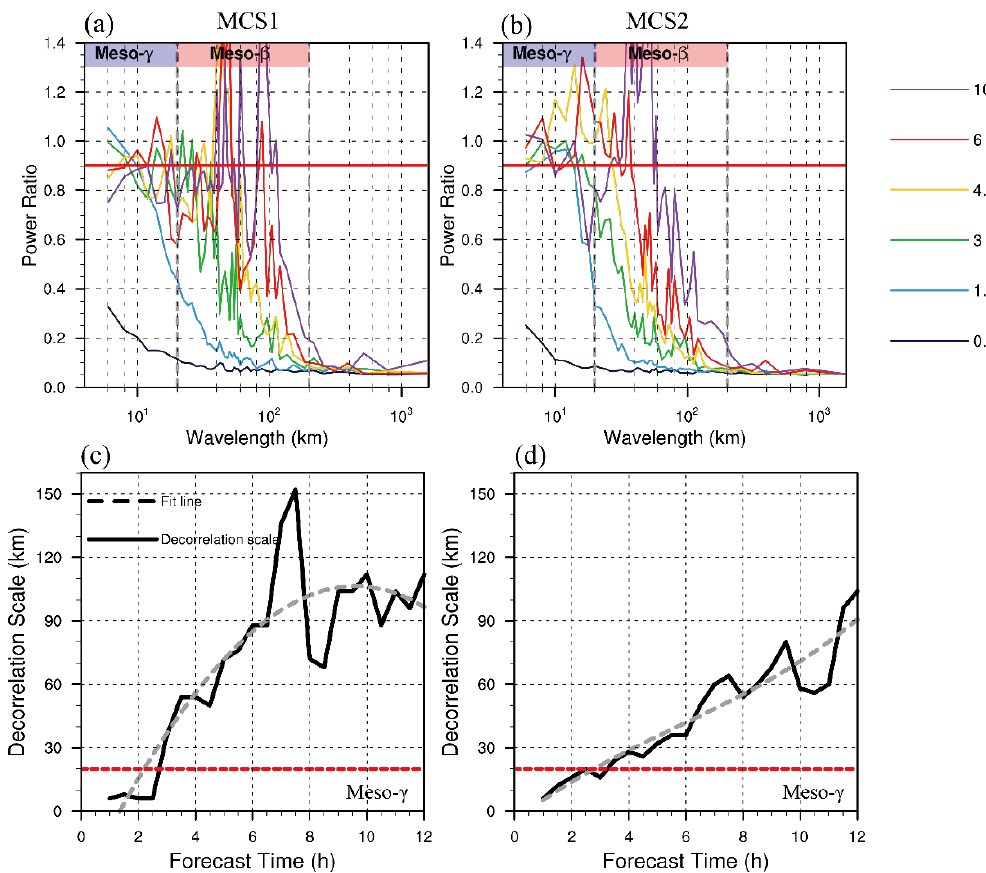
Figure 7. The power ratio as a function of spatial scale for different lead times in the (a) MCS1 region and (b ) MCS2 region. The decorrelation scale as a function of lead time with the dotted gray line showing a logarithmic fit in the (c) MCS1 region and (d) MCS2 region.